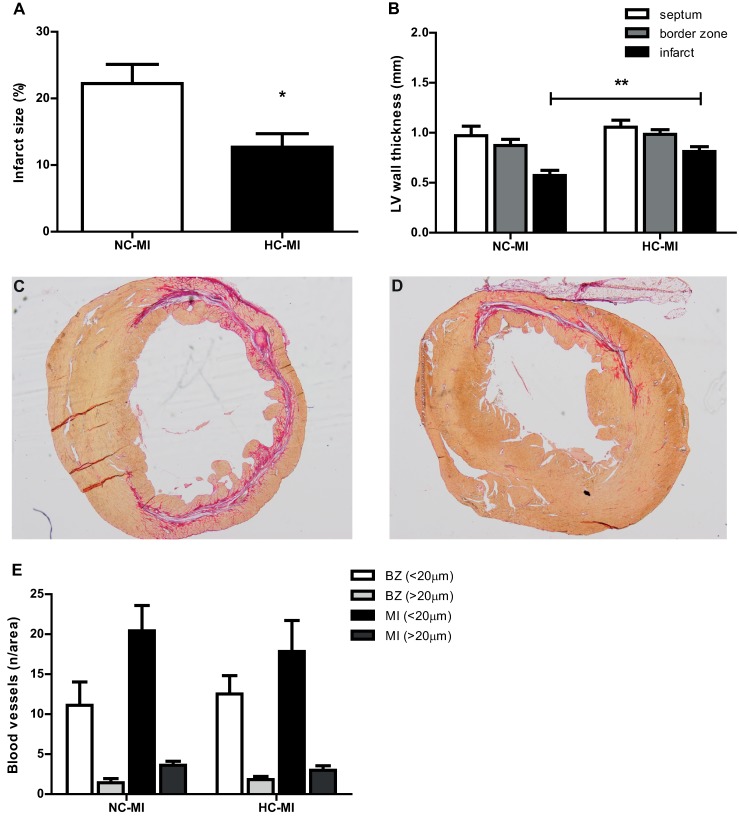
Infarct size, LV wall thickness, and vascular profile 8 weeks after MI-R.Infarct size (n = 8) was significantly smaller in the HC-MI group compared with the NC-MI group (A). Wall thickness of the infarct area was significantly larger in the HC-MI group (B). Sirius red staining in the HC-MI group showed a more pronounced subendocardial and epicardial border of surviving cardiomyocytes in the HC-MI group (D) compared to the NC-MI group (C). Vascular analysis showed no differences in number of small capillaries (<20μm) or large vessels (>20μm) in the border zone (BZ) or infarct area (MI) between both groups (E). Data are means ± SEM. *P<0.05, **P<0.01.